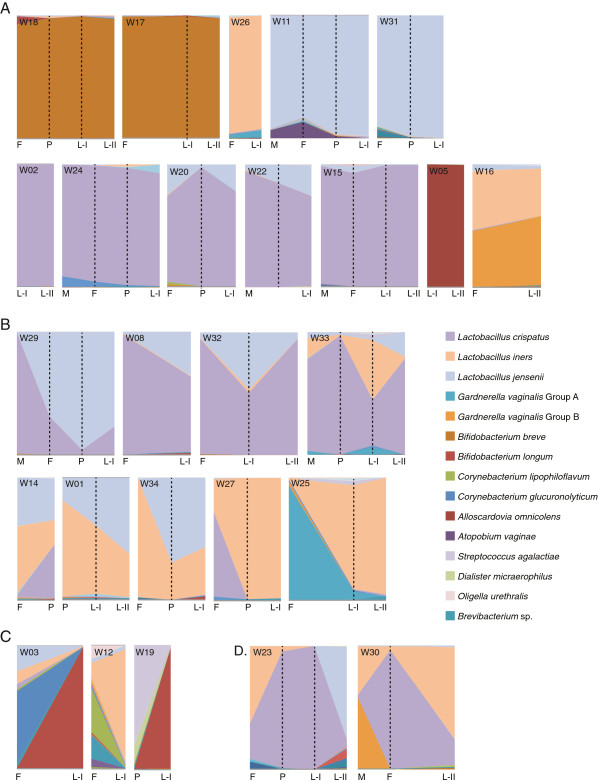
Vaginal microbiome profiles over the menstrual phase. Data are presented as proportion of the total sequence reads obtained for each sample, with the height of the ordinate corresponding to 100%. Sampling times are indicated with vertical broken lines, and menstrual-cycle phase for each sample is indicated on the abscissa (M, menstrual; F, follicular; P, periovulatory, L-I, luteal I; L-II, luteal II, as defined in the text). Profiles are arranged to reflect women with relatively stable microbiomes (<25% change) (A), profiles consisting of the same organisms, but the proportions of these organisms fluctuated by >25% over time (B), profiles that had dramatic changes over the sampling time (C), and profiles with a mixture of changing proportions and introduction of new organisms (D). Sample identification numbers appear in the upper left corner for each individual. The legend includes nearest-neighbor "species" that account for at least 10% of the sequence reads in at least one sample.